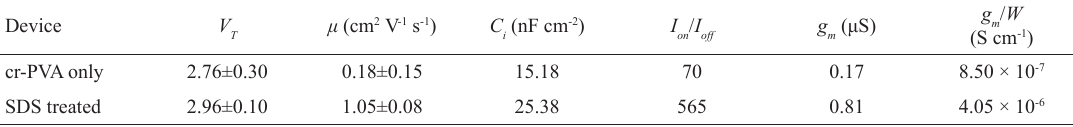
Table 1: Device performance parameters for untreated and SDS treated C at V = 6 V. DS